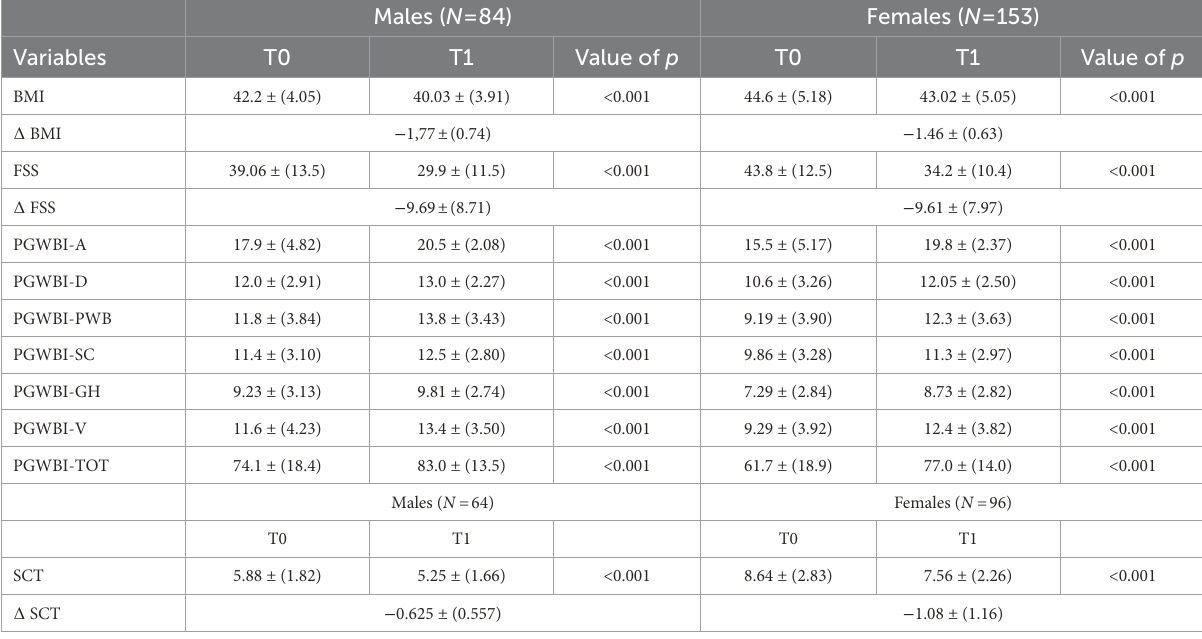
TABLE 1 Descriptive characteristics of the study